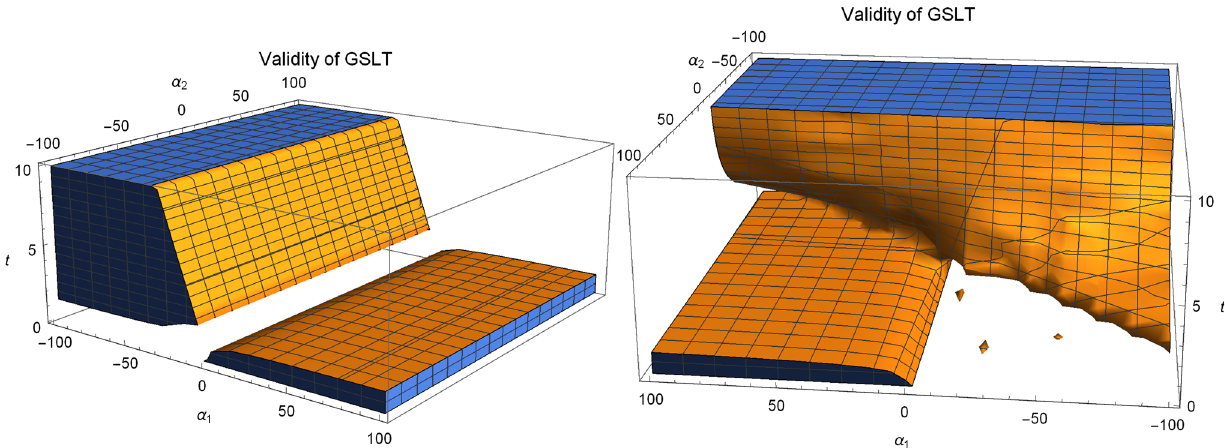
Fig. 10 Left plot represents the validity regions for logarithmic corrected entropy in intermediate case with δ = 0, right graph corresponds to evolution of GSLT for δ = 2. Herein, we set λ 1 = 2 and λ 2 = 3